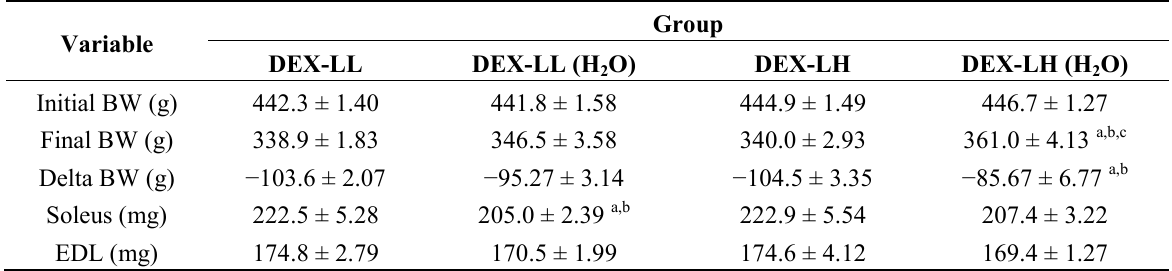
Table 3. Body and muscle morphological parameters of the experimental